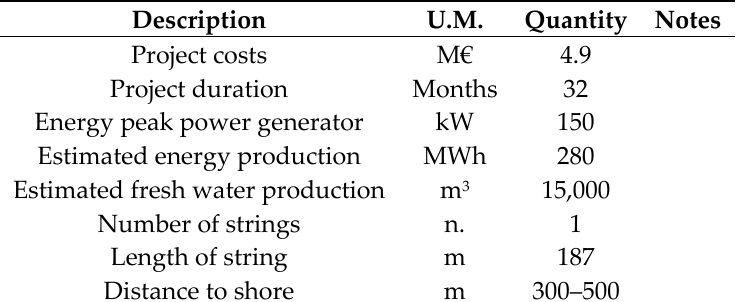
Table 2. Dimensional data input.